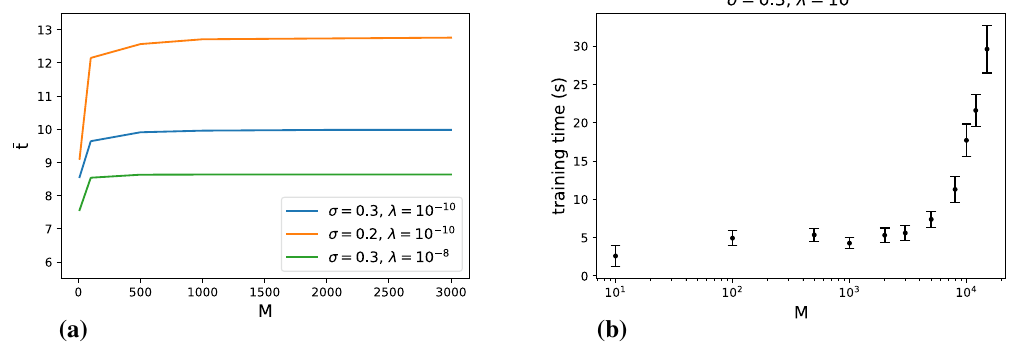
Fig. 10 a Average test statistics as a function of the number of Nyström centers. b Average training time as a function of the number of Nyström